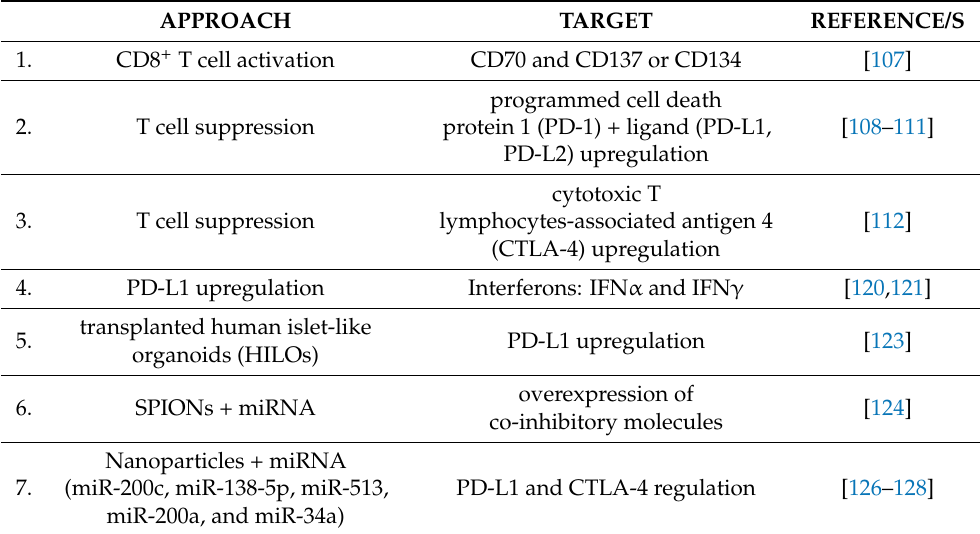
Table 3. Summary of strategies for identifying and targeting immune checkpoint markers to- wards